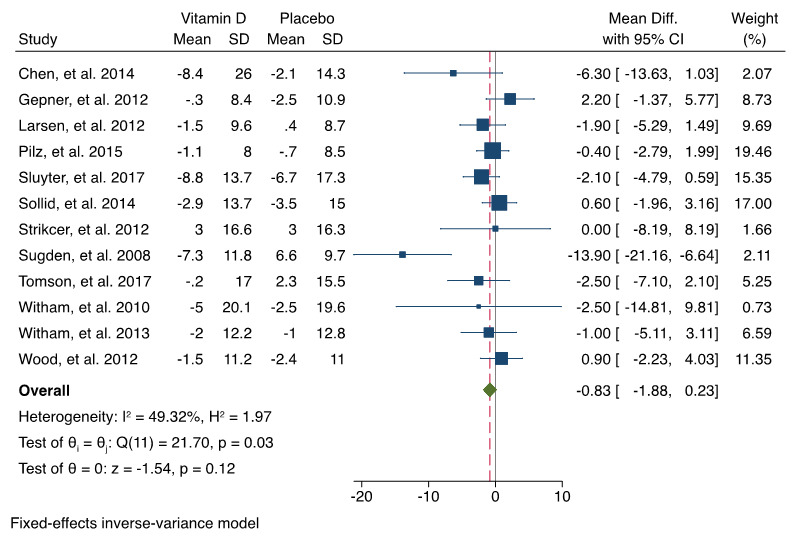
Forest plot of systolic blood pressure changes from the baseline.The overall effect size estimate is represented by the red dashed line. CI, confidence interval; SD, standard deviation.